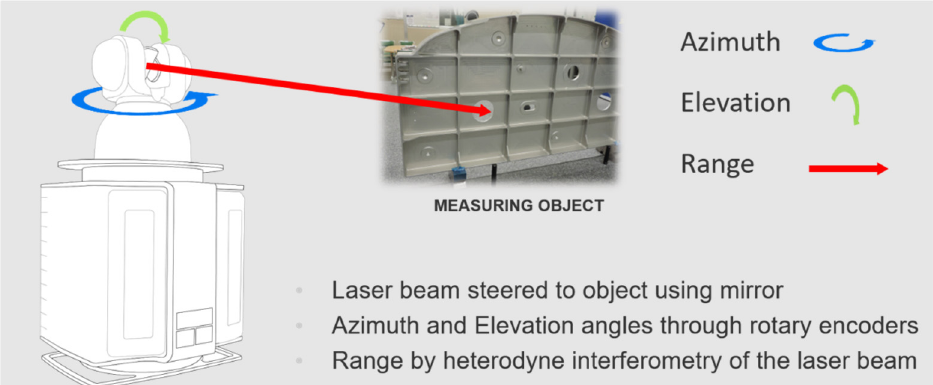
Figure 5. The principal functional operation of a laser radar for absolute distance measurements, using heterodyne interferometry for automatic non-contact dimensional measurements. By the courtesy of LK Scandinavia.